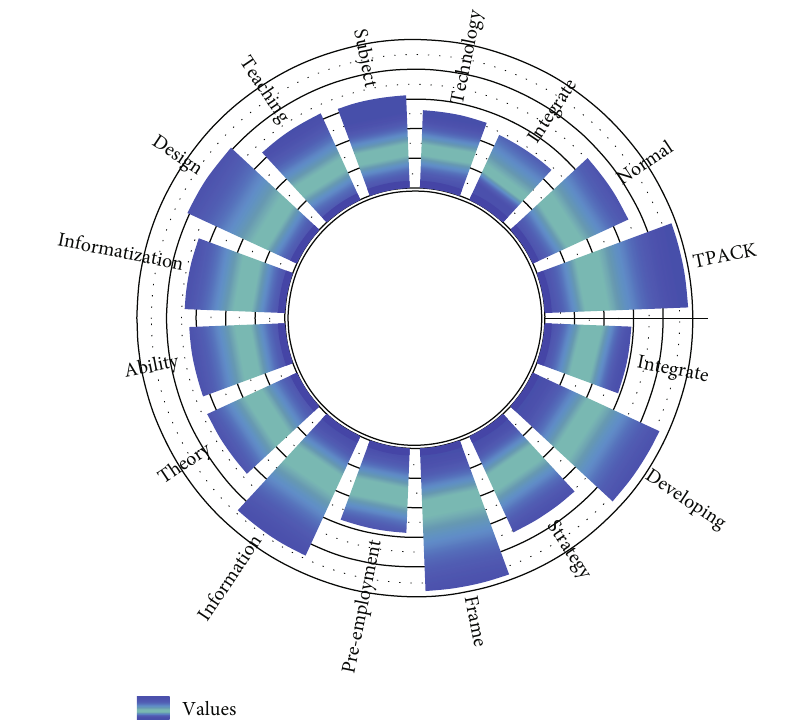
Figure 2: Theme distribution